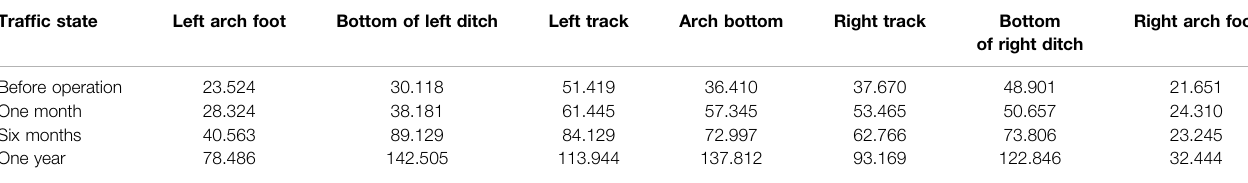
TABLE 1 | Contact pressure of surrounding rock of Taihangshan tunnel basement